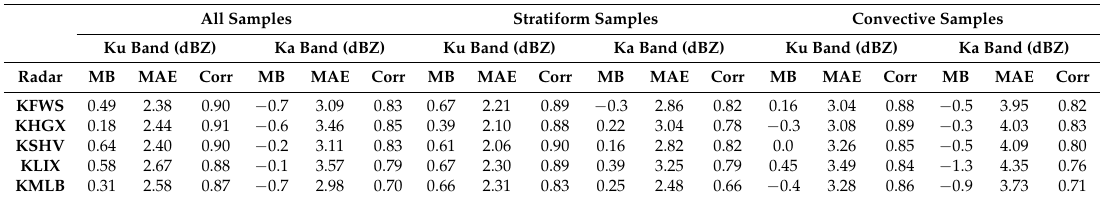
Table 2. Table summarizing different error statistics for comparison of DPR Ku-band and Ka-band reflectivity vs NEXRAD S-band reflectivity. All